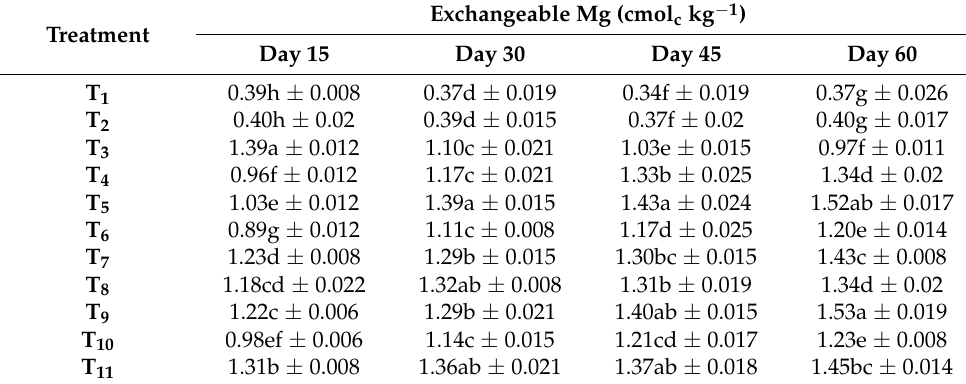
Table 10. Effect of RHB, EFBB, and dolomitic limestone treatments on soil exchangeable Mg.